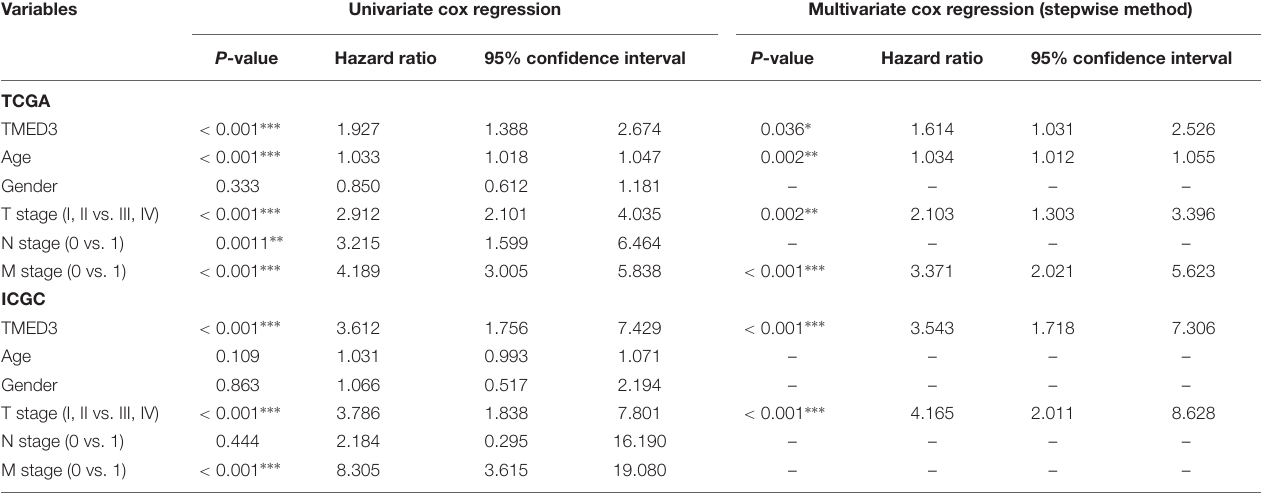
TABLE 3 | Univariate and multivariate analysis of overall survival in each cohort. Variables